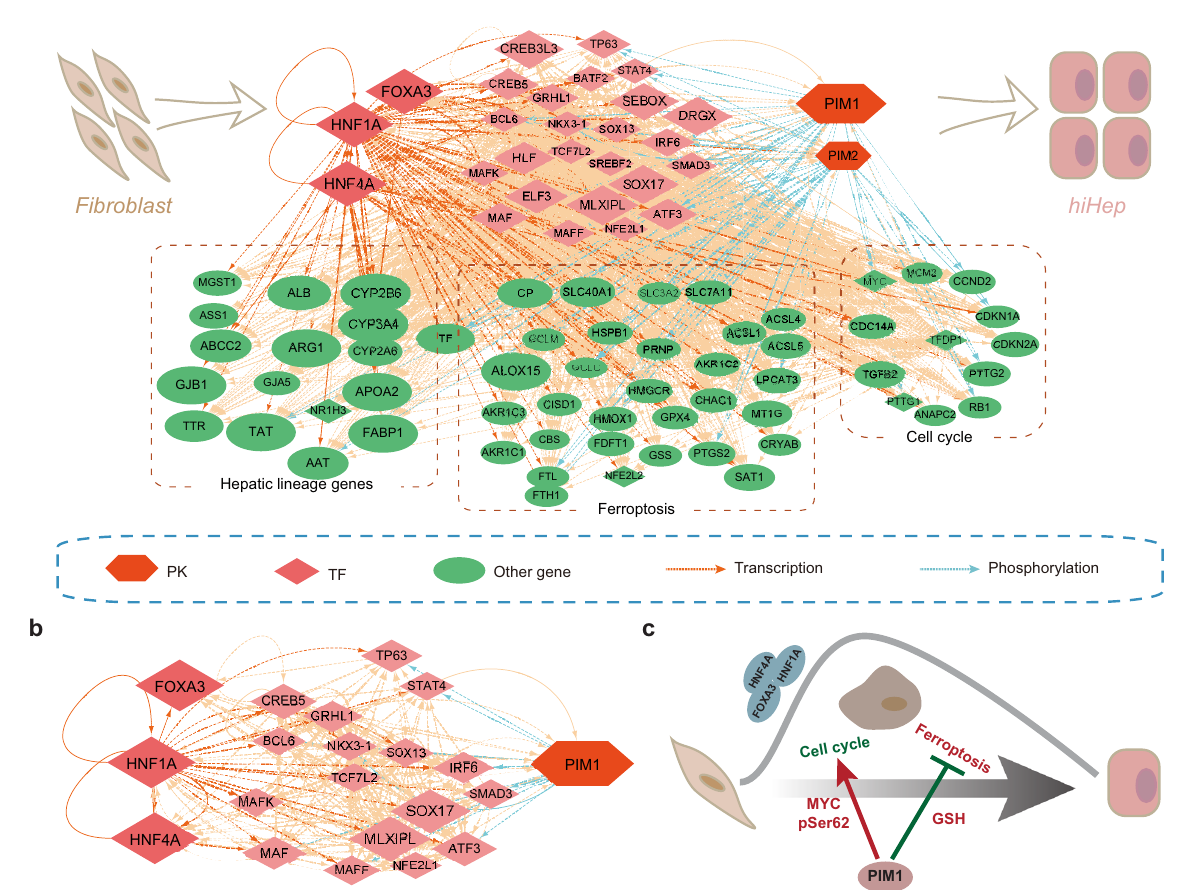
Fig. 7 | Network analysis of the major molecular landscape in hepatic reprogramming. a An integrative TPCW based on the fi ndings of this study and existing knowledge illustrates the regulatory relationships among FHH, 24 FHH- regulated TFs, two screened central PKs, and 60 curated genes related to hepatic